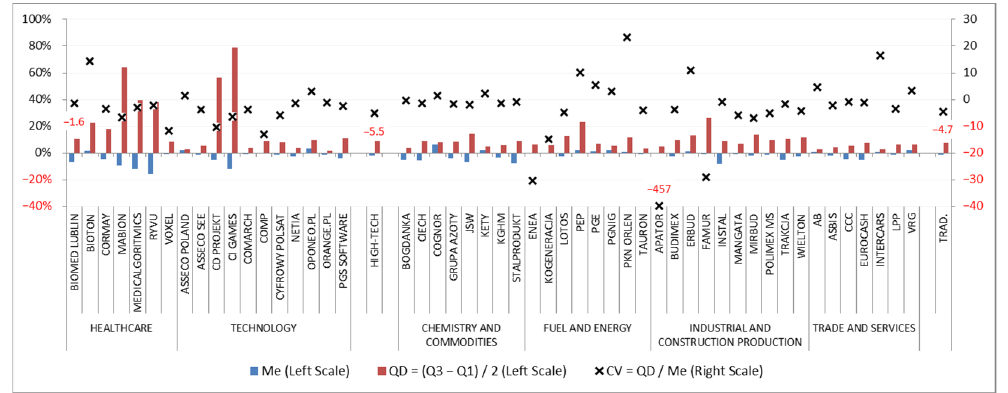
Figure 12. Assessment of the variation of asset productivity in the surveyed enterprises. Source: own work.